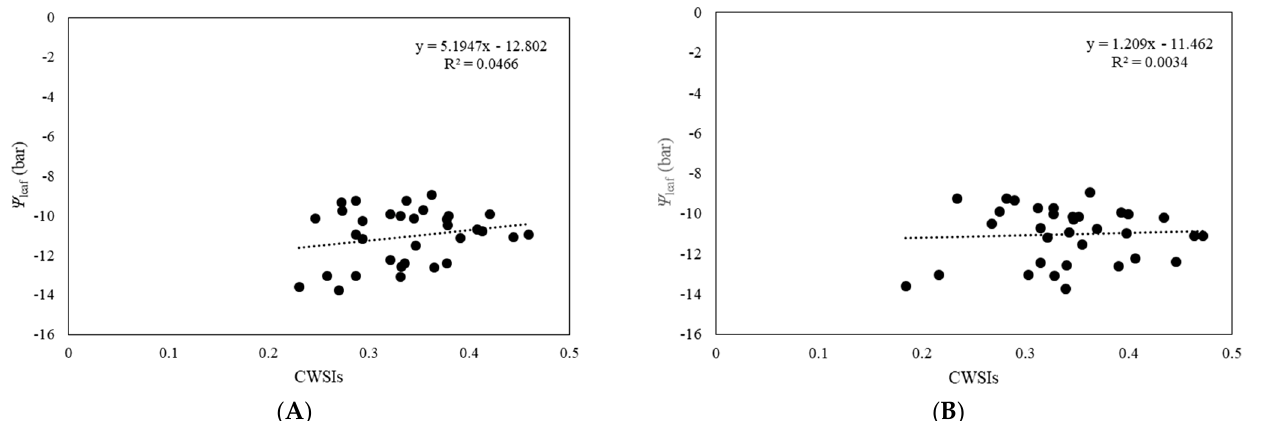
Figure 9. Correlation between CWSIs and Ψ leaf in the ( A ) shaded side and ( B ) sunlit side of the canopy.